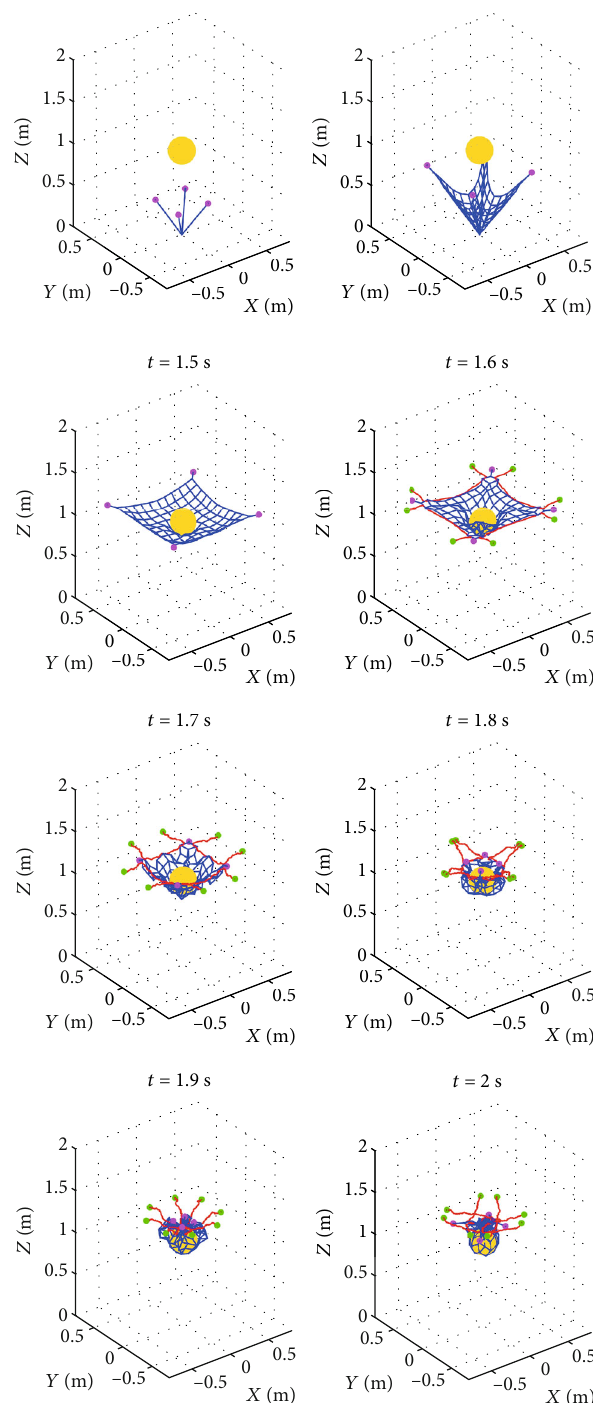
Figure 11: Closure sequence of the